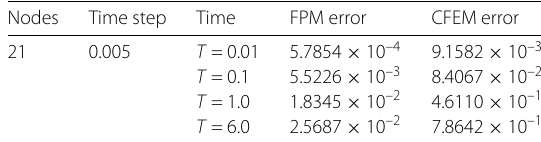
Table 7 Comparison of calculation results of FPM and CFEM